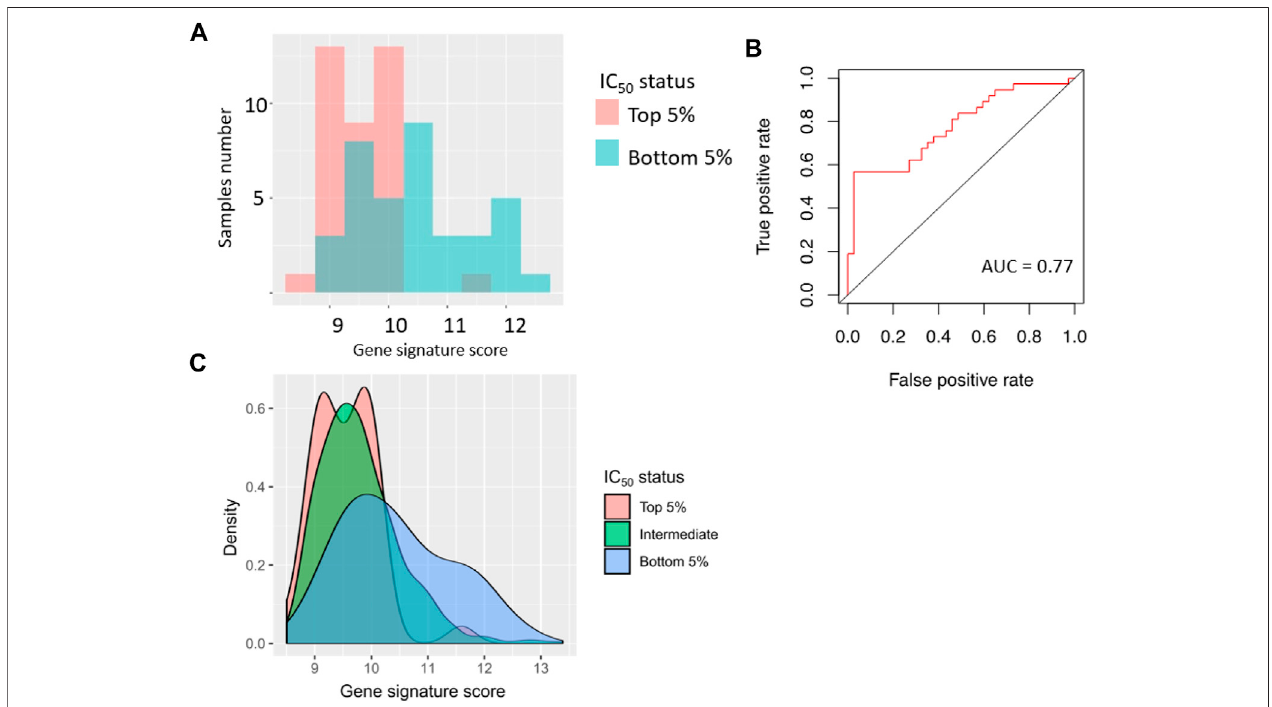
FIGURE 6 | Performance of sorafenib response gene signature in 76 cancer cell lines (top 5% and bottom 5% cell lines from GDSC dataset, sorted by sorafenib IC 50 ). (A) Distributionofgenesignaturescorein76cancercelllines. (B) ROC(receiver operating characteristic)curveforprediction ofresponsestatus bygenesignature score in 76 cancer cell lines. (C) Distribution of gene signature score in all cancer cell lines.